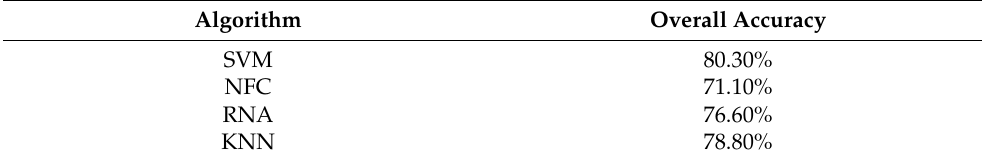
Table 3. Performance of classifiers using the original testing data